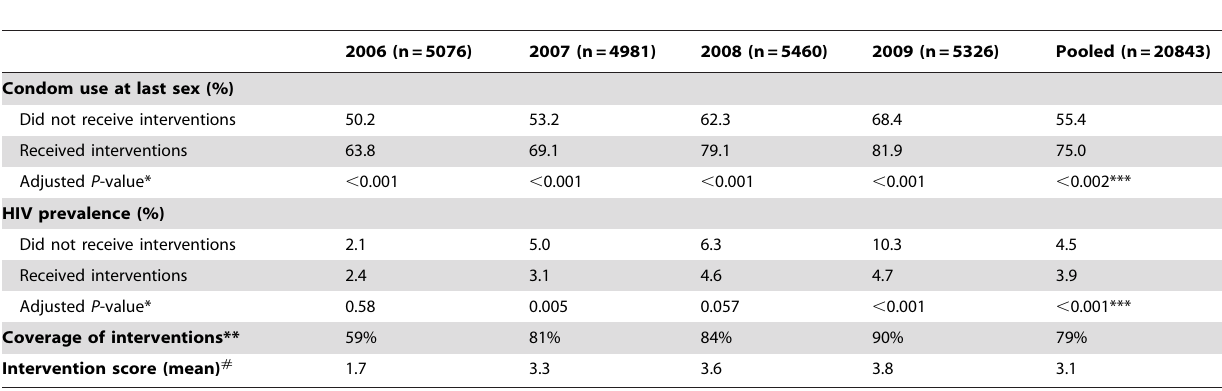
Table 5. Comparison of condom use at last sex and HIV prevalence by receipt of any interventions in the past 12 months among MSM surveyed in 16 Chinese cities from 2006 to